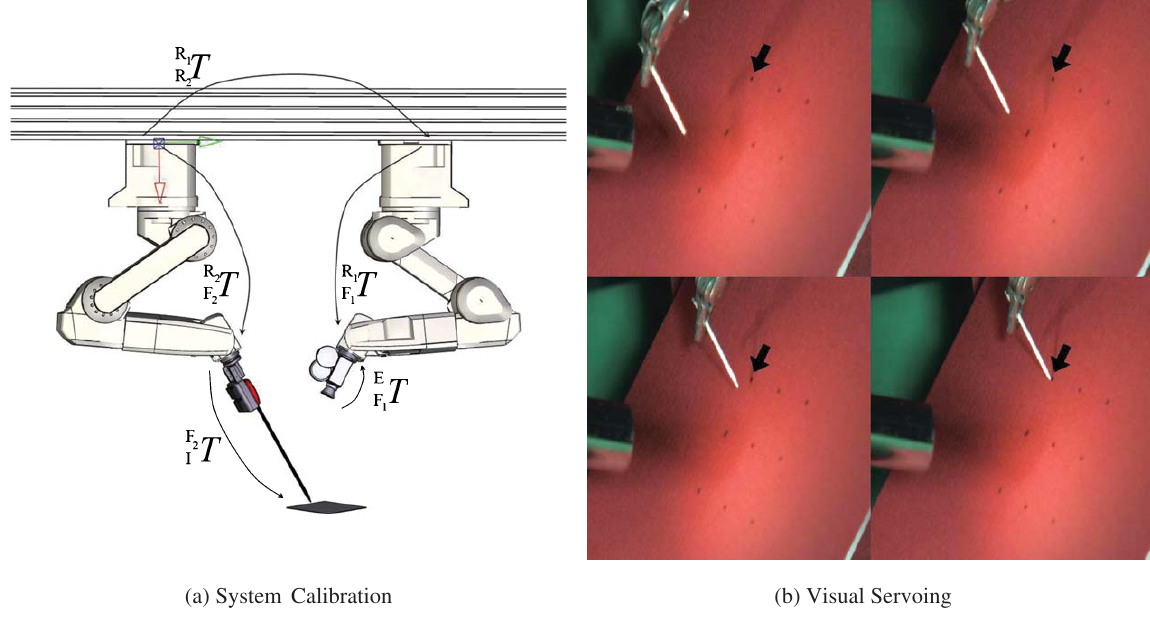
Fig. 6. Illustration (a) exemplifies the intrinsic system aberrations that yield to a comparable bad overall system accuracy, i.e. the error of the flexible carbon fiber shaft of the instruments cannot be calibrated perfectly. The top left image in (b) shows the initial position of a needle that is to be driven to the marked dot. The final posture is reached in the bottom right